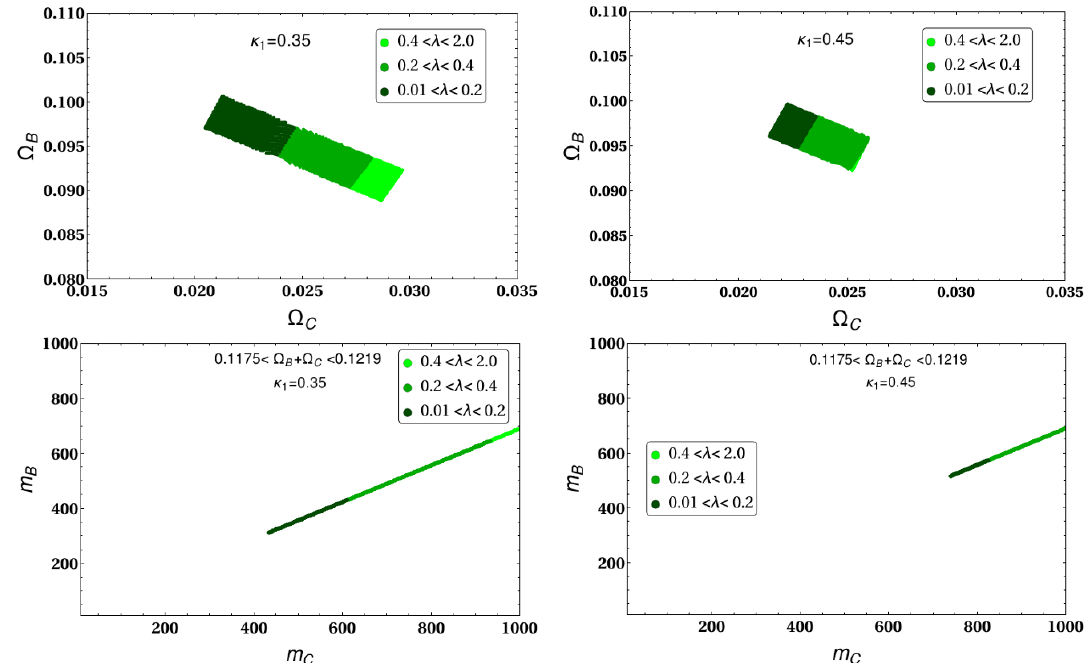
Figure 8 . [Top panel:] Contribution to (cid:10) T from (cid:10) C and (cid:10) B for di(cid:11)erent choices of (cid:20) 1 = 0 : 35 (left) and 0.45 (right). Di(cid:11)erent ranges of (cid:21) are indicated (cid:21) = f 0 : 01 (cid:0) 0 : 2 g (dark green), f 0 : 2 (cid:0) 0 : 4 g (green) and f 0 : 4 (cid:0) 2 : 0 g (lighter green) respectively. [Bottom panel:] Mass correlation ( m B (cid:0) m C ) in allowed relic density parameter space. Color codes remain the same as in top panel.